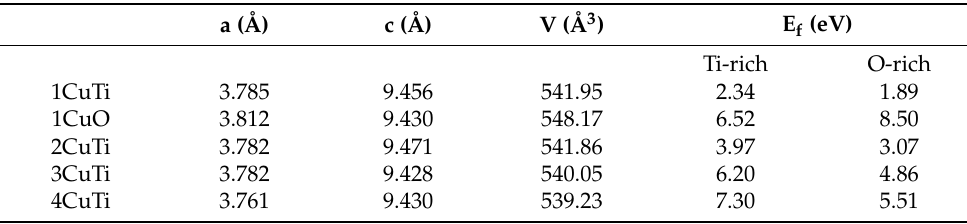
Figure 1. ( a ) The optimized geometric structure of 2 × 2 × 1 supercell and ( b ) computed electronic band structure and total/partial of pure TiO 2 . (Ti in dark gray, O in red, orange circle of doping atom). The computed energies of formation for single Cu doping into TiO 2 at both the Ti and O sites are gathered in Table 1. It indicates that the Cu dopant preferred to replace the Ti site both under Ti-rich and O-rich environments which is the most energetically favorable structure. Table 1. The optimized lattice parameters, cell volume and the formation of defects for pristine and modified TiO 2